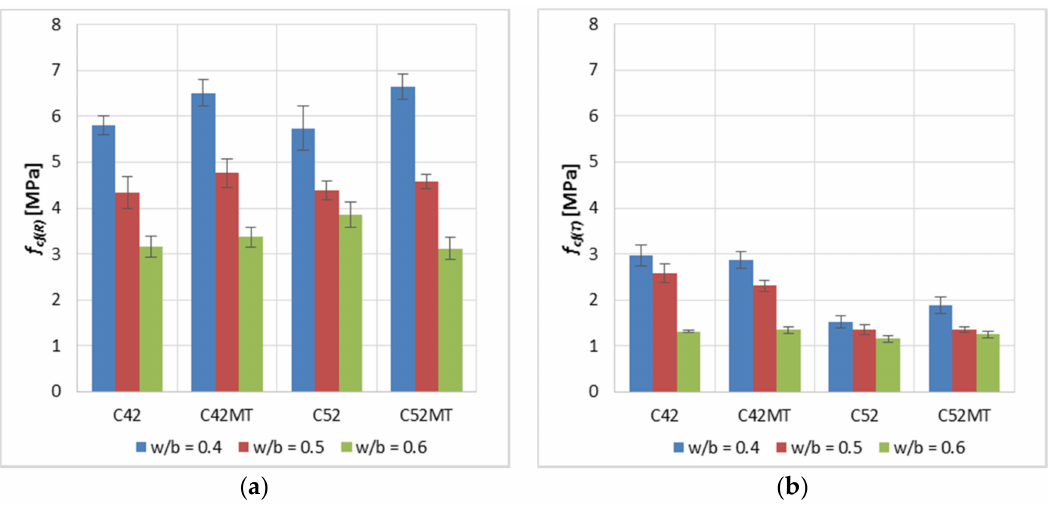
Figure 4. Average tensile strength f cf of the modified cement pastes (error bars mean standard deviations): ( a ) reference samples; ( b ) samples after thermal load.